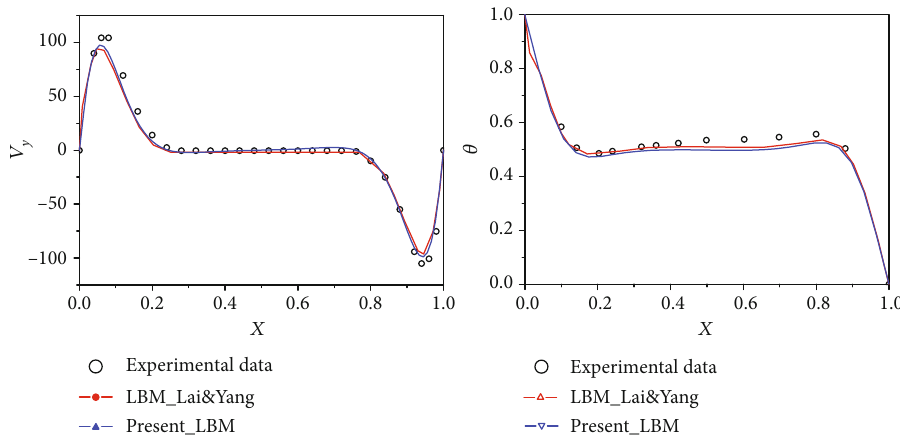
Figure 3: Temperature pro fi les and nonnormalized y -component velocity as a function of x -coordinate for Ra = 1 : 89 × 10 5 , in the case of air fl ow in full convection. Table 1: Average Nusselt number variation for di ff erent mesh size. Mesh